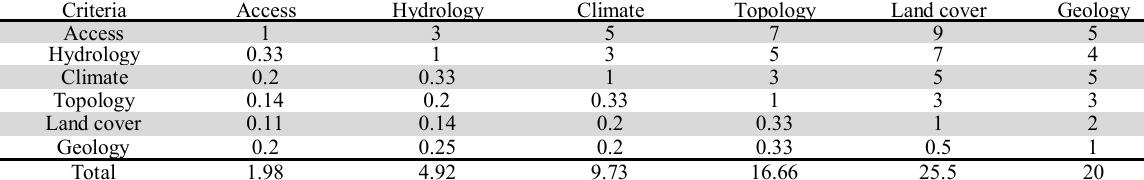
The priority OF Criteria’s preference relative to each other Criteria Access Hydrology Climate Topology Land